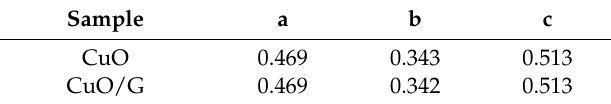
Table 1. Lattice constants of CuO and